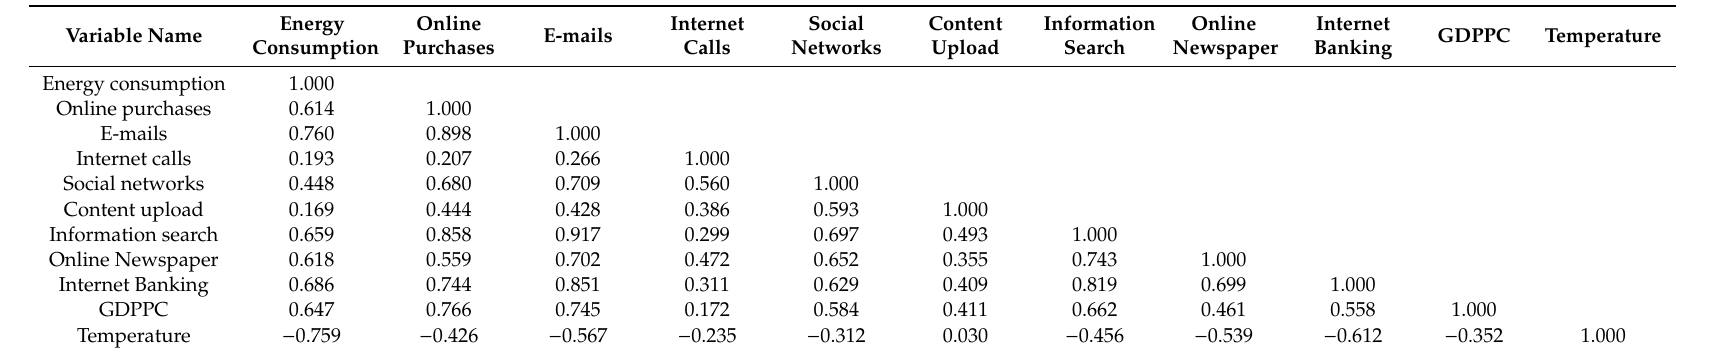
Table 2. Correlation between the